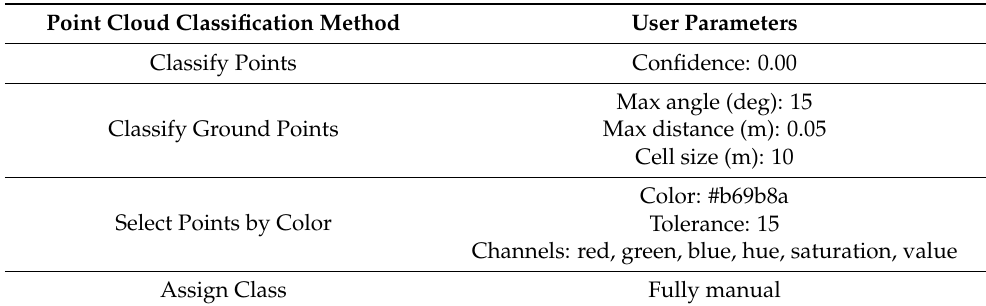
Table 1. Methods of point cloud classification in Agisoft Metashape Professional and the correspond- ing user parameters used to produce optimal DTMs at